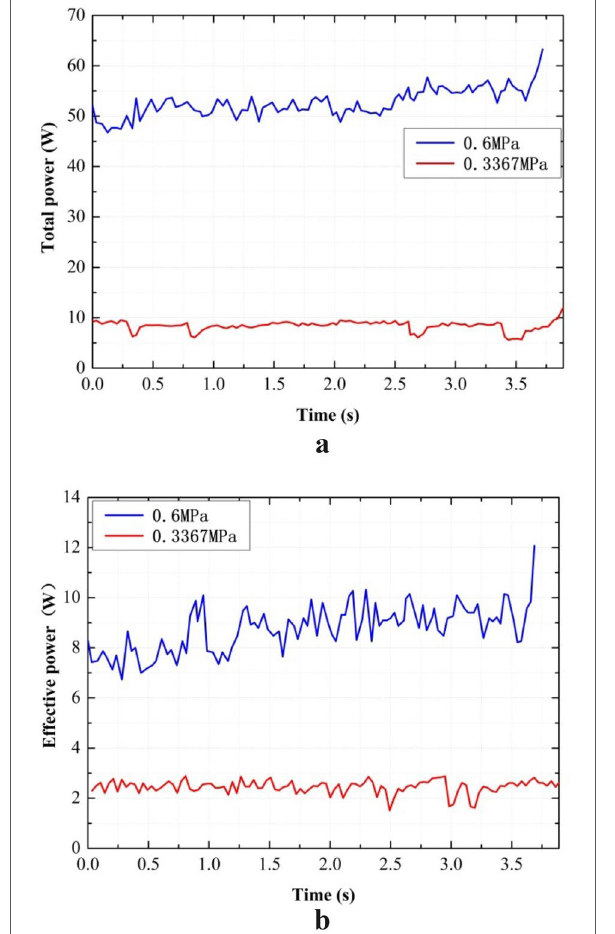
Figure 11 Total and effective power of the pneumatic system under different supply pressure values: ( a ) Total power, ( b ) Effective power